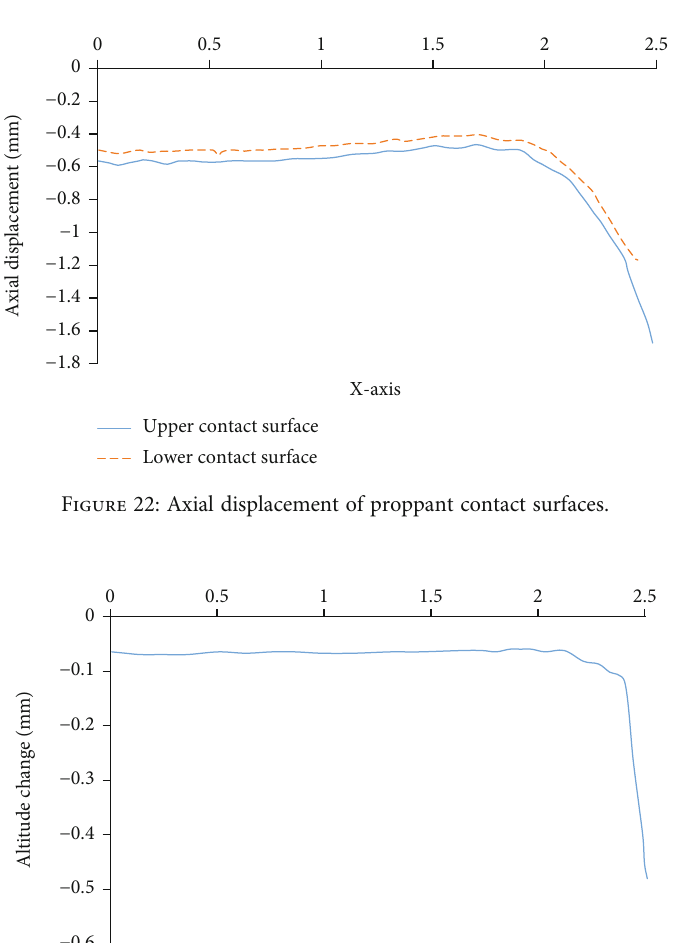
Figure 21: Total fracture area and e ff ectively propped fracture zone.